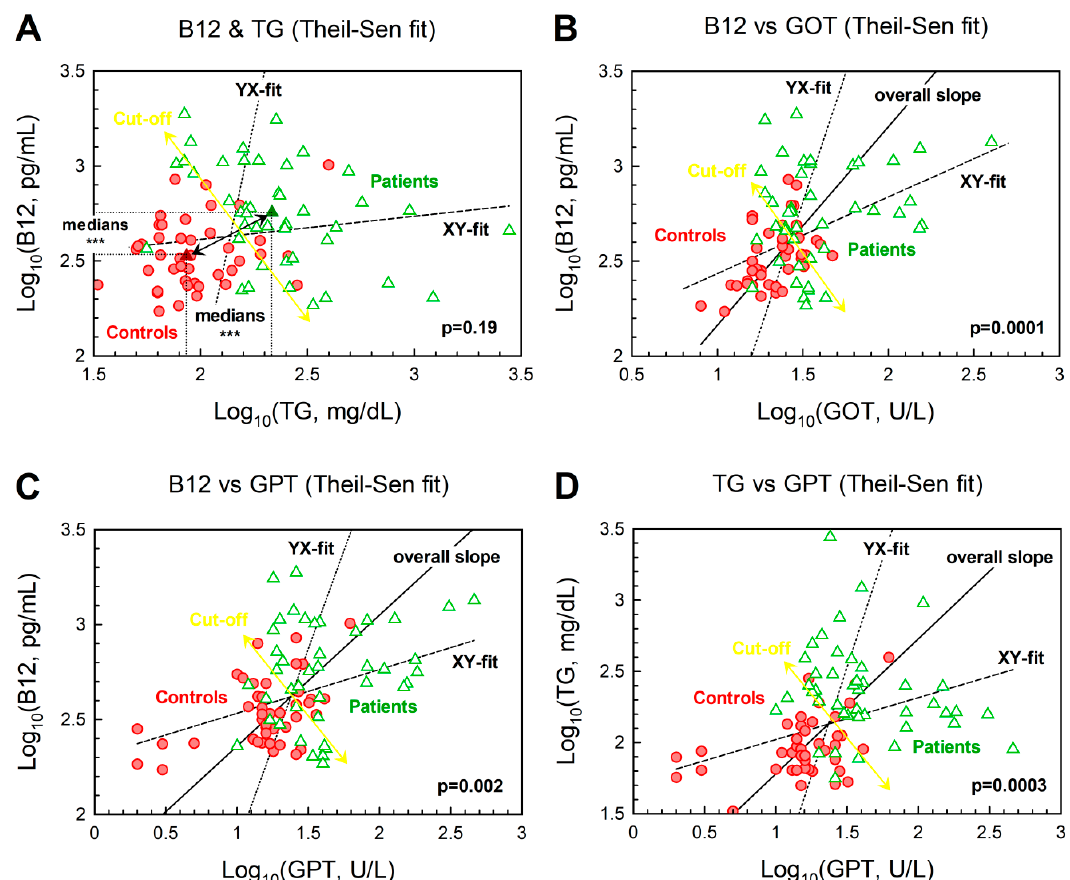
Figure 4. Correlations (Theil ‐ Sen method) between biomarkers presented in logarithmic coordinates. Panels show ( A ) Triglycerides (TG) and vitamin B12; ( B ) GOT and B 12 ; ( C ) GPT and B 12 ; ( D ) GPT and TG. Data from cohorts of controls and GSD patients are notated as red circles and green triangles, respectively. Linear fitting was done by the median ‐ based Theil ‐ Sen method, and the fitting functions correspond to the direct X,Y ‐ coordinates (dashed line, y = b0x + b1x ∙ x) and the inverted Y,X ‐ coordinates (dotted line, x = b0y + b1y ∙ y). The overall slope vector of transformation of ‘healthy → GSD’ is shown as a solid line (for the cases, where the probability of zero slope is below 0.05). Cut ‐ offs between 2D distributions of controls and GSD are indicated as yellow double ‐ headed arrows. Panel A also shows medians of the two cohorts, as well as probabilities of equal sets (controls = patients), assessing them along axes X and Y.